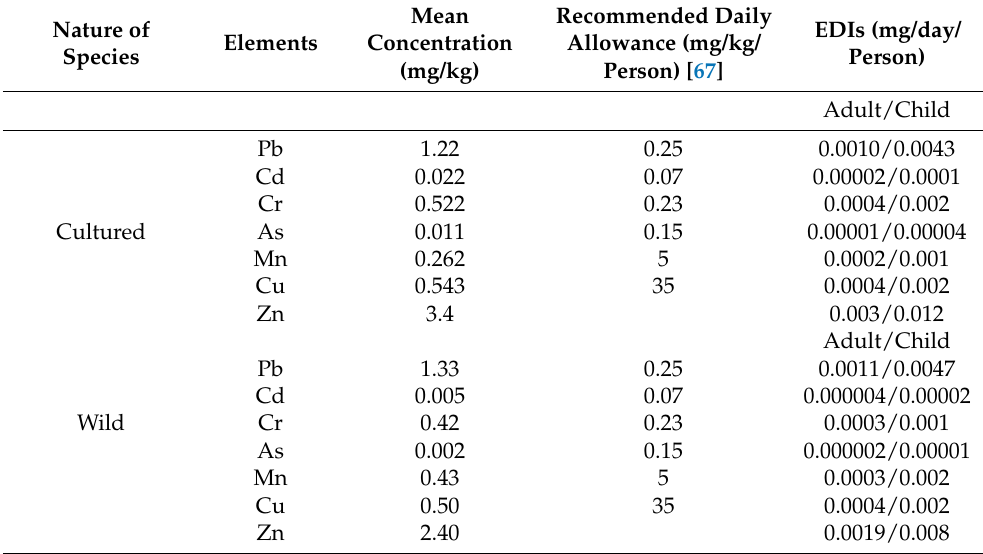
Table 5. A comparison between recommended daily allowance (RDA) and estimated daily intake (EDI).